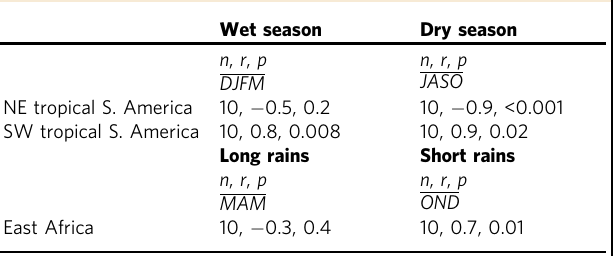
Fig. 3 Correlations between meteorological analyses and variations in CH 4 emissions. (left) spatial distribution of Pearson correlations ( R 2 , unitless) between monthly values of the NOAA OISST anomaly and CMAP rainfall anomaly and (right) comparison of a posteriori CH 4 fl uxes (g/m 2 /year, red lines) with linear (f l ) and quadratic (f q ) regression models fi tted to the 3-month moving means of CMAP rainfall, MERRA2 surface temperature, and MERRA2 soil moisture anomalies (2010 – 2019) over ( a ) NE tropical South America and ( b ) SW tropical South America during the wet season (DJFM); and over c East Africa during the short rains (OND). Purple rectangles in l.h.s. panels denote the geographical regions over which SST and rainfall are correlated. Shaded regions with crosses denote statistical signi fi cant values ( P < 0.1). Blue and red numbers atop of each r.h.s. panel denote the correlation r between the regional a posteriori CH 4 fl ux and the linear and cubic regression models, respectively. Table 2 Seasonal mean correlations between (upper table) a posteriori CH 4 emission anomalies over NE and SW tropical South America (Fig. 3) and tropical Paci fi c – Atlantic dipole (PAD) SST anomalies, and (lower table) a posteriori CH 4 emission anomalies over tropical Africa (Fig. 3) and Indian Ocean dipole (IOD) SST